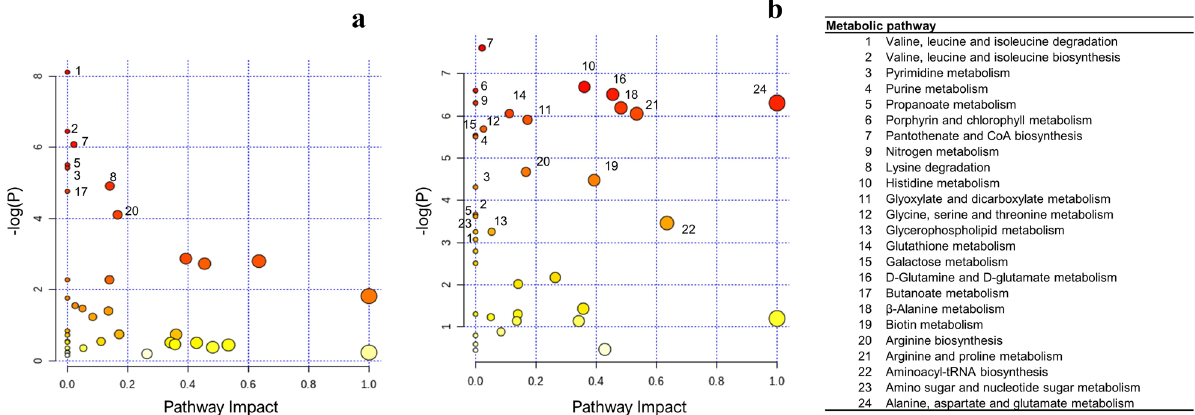
Figure 3. Metabolic pathway analysis comparing Low versus High-RFI animals in corn- ( a ) and grass-silage ( b ) diets according to Bos taurus KEGG database. Numbers indicate metabolic pathways differing between RFI groups within each given diet. More red tones denote lower P values, while greater circle sizes denote greater impact Results from a PCA performed a posteriori only from those variables significantly different across RFI (Fig. 4) indicated that plasma concentration of insulin and BCAA, and visceral fat mass were positively correlated with RFI in the corn diet (PCA first component; 38.7%). In contrast, these same variable as well as plasma triglycerides showed a negative association with RFI in the grass diet (PCA first component; 42.6%) (Fig. 2). Metabolic pathway analysis. Metabolic pathway analysis revealed 7 and 16 metabolic pathways differ- ing ( FDR < 0.05) between RFI groups in the corn and grass diets, respectively (Table 4, Fig. 3). Among these metabolic pathways, pantothenate and CoA biosynthesis, and pyrimidine metabolism were shift-regulated between RFI groups in both diets. While pyrimidine metabolism was up-regulated in Low-RFI animals in both diets, pantothenate and CoA biosynthesis was down-regulated in the corn diet and up-regulated in the grass diet (Fig. 4). In the corn diet, most of metabolic pathways were associated with lower plasma concentration